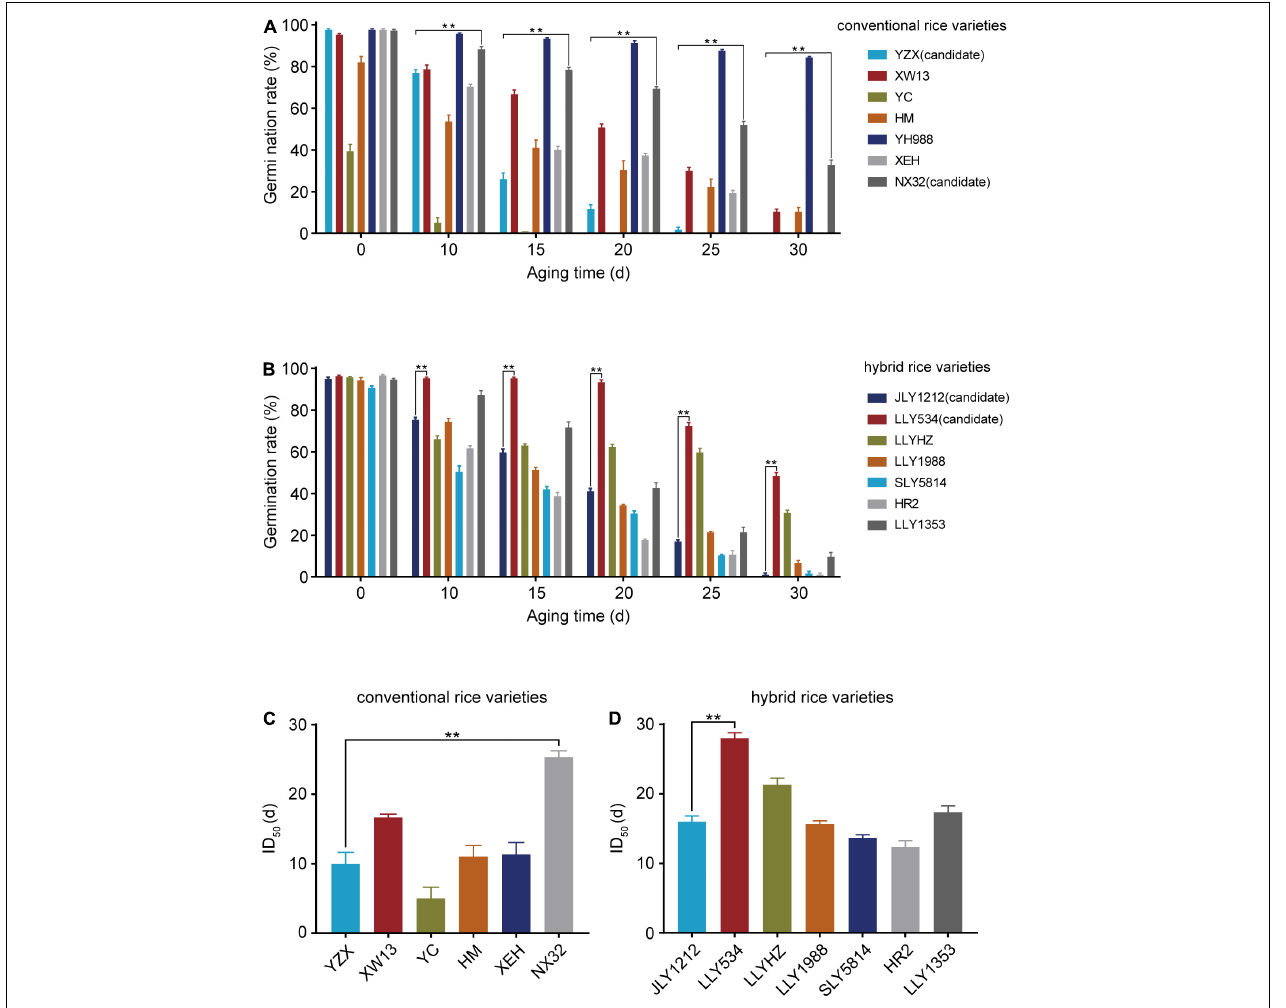
FIGURE 1 | Germination rate and ID 50 of conventional and hybrid rice seeds. (A,B) Germination rates of seven conventional (A) and seven hybrid rice varieties (B) after artificial aging treatment. The germination rates were recorded after the seeds germinated for 8 days. The experiments were repeated three times, and the error bars represent the SDs of three biological replicates (** P < 0.01, one-way ANOVA with Tukey’s test). (C,D) Half maximal inhibitory days (ID 50 ) of six conventional (C) and seven hybrid varieties (D) . YH988 is not shown because it did not reach ID 50 after 30 days artificial aging. Data are the means ± SDs based on three biological replicates (** P < 0.01, one-way ANOVA with Tukey’s test).